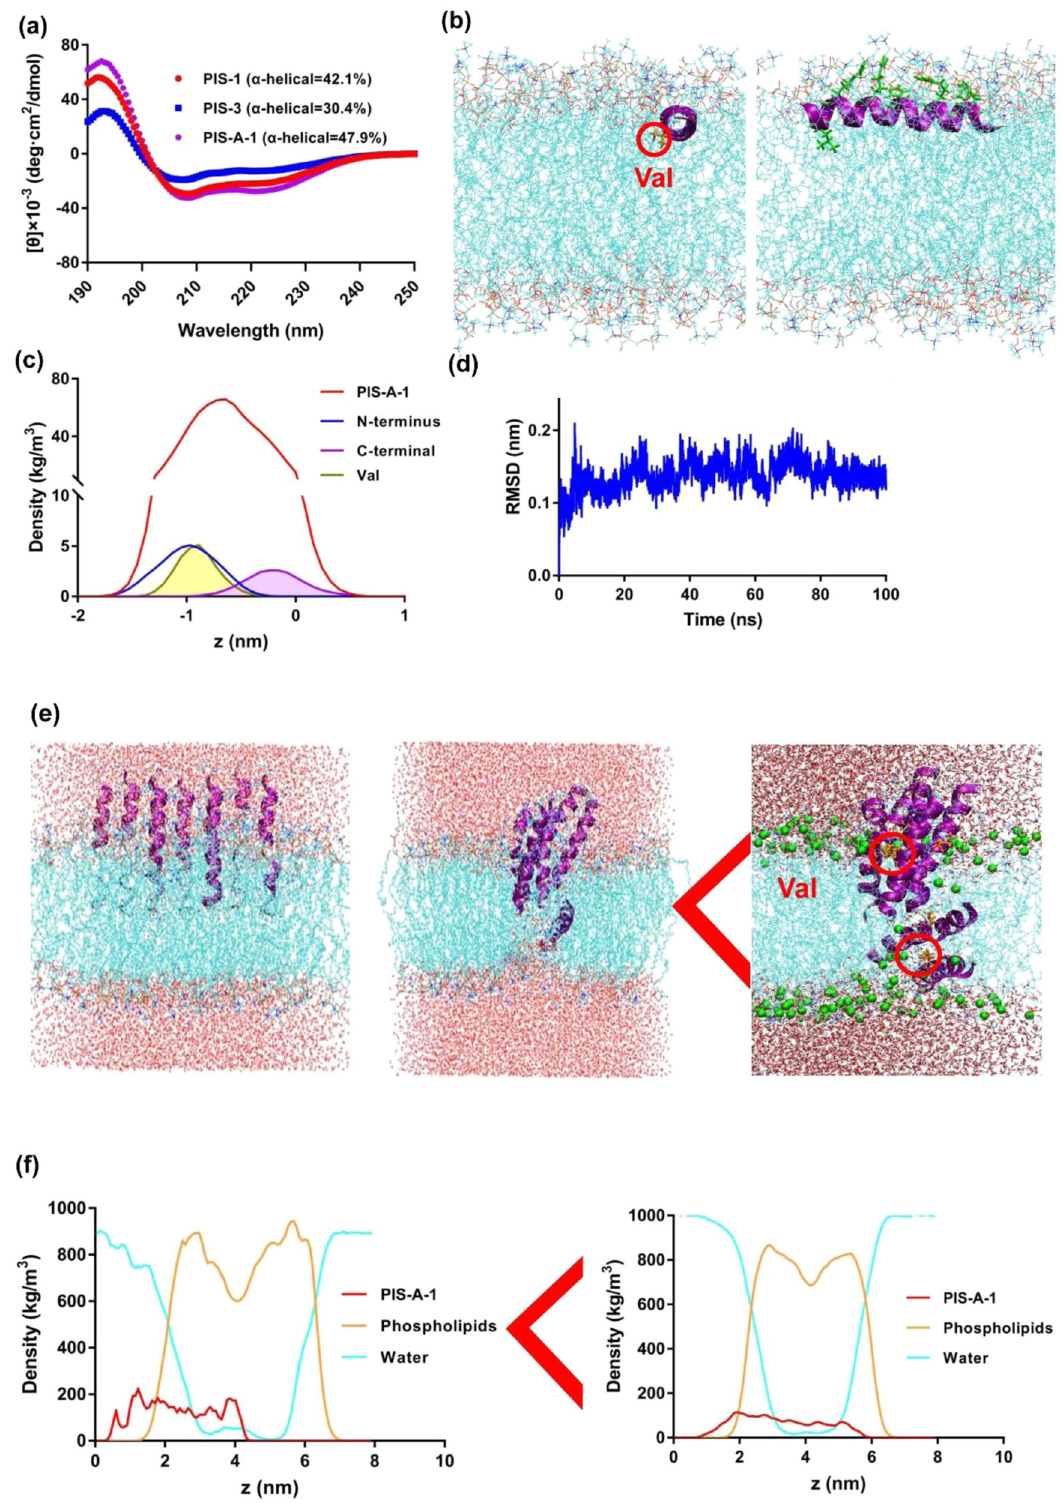
Fig. 4 The in fl uence of the environment on the structure of PIS-A-1. a CD spectrum of PIS-A-1. b Folded monomer inserting terminally into the membrane (top view), and folded monomer lying fl at on the membrane surface (side view). Val in PIS-A-1 is marked in orange. c Mass density pro fi le of folded monomer along the z-axis (normal to the membrane). d RMSD of folded monomer. e Snapshots of multiple PIS-A-1 forming transmembrane pores. f Mass density pro fi le of multiple PIS-A-1 along the z-axis (normal to the